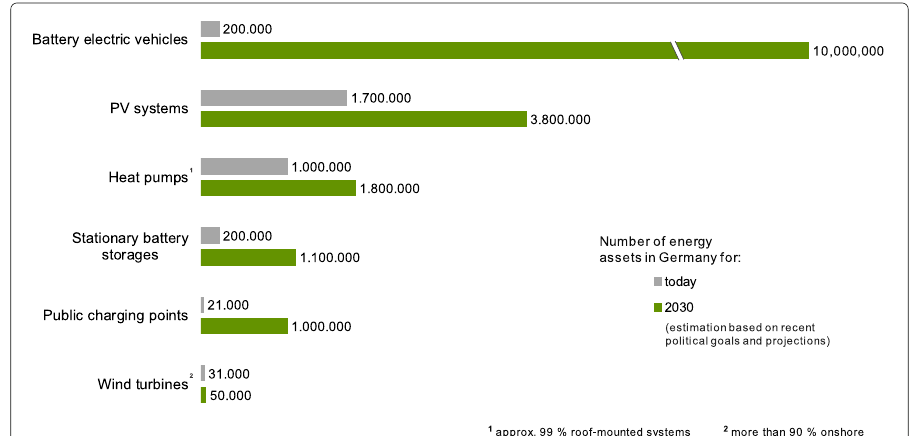
Fig. 1 Estimation of the number of units in different fields that are relevant for asset logging, based on national policy goals, such as Bundesministerium für Umwelt (2020) for battery electric vehicles, and own calculations derived from simulations of the future energy system (Fattler et al.